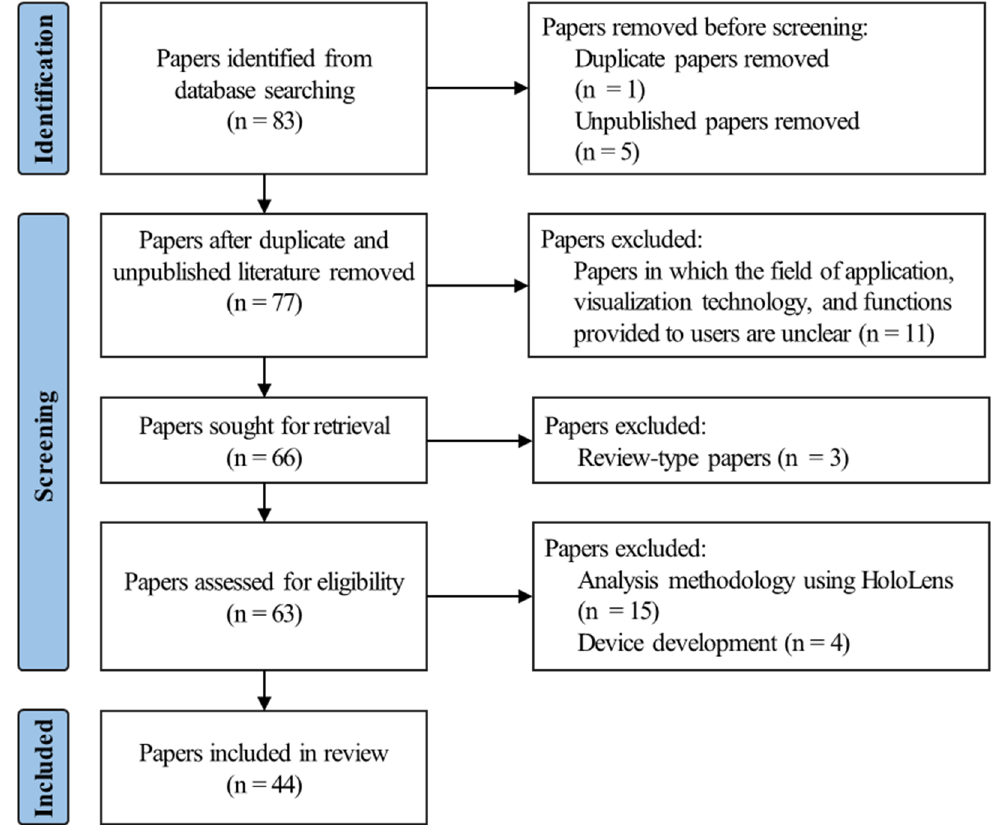
Figure 1. Flow diagram for selecting papers to achieve research objectives.